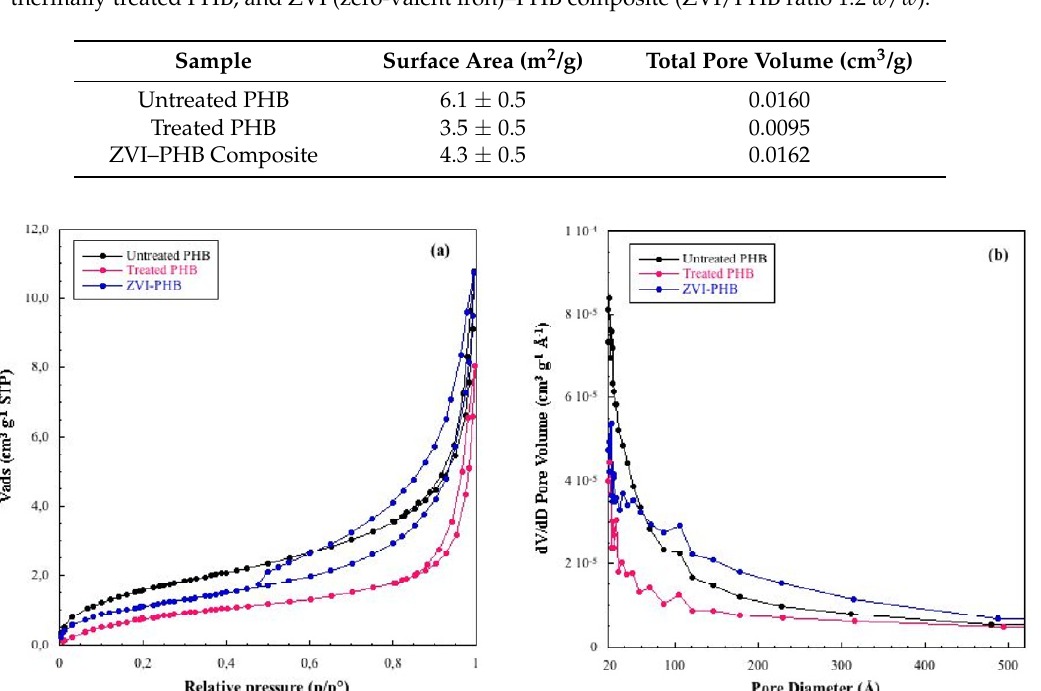
Figure 4. Thermogravimetric analysis (TGA) of thermally treated PHB and ZVI–PHB composite samples (ZVI/PHB ratio 1:2 w / w ).